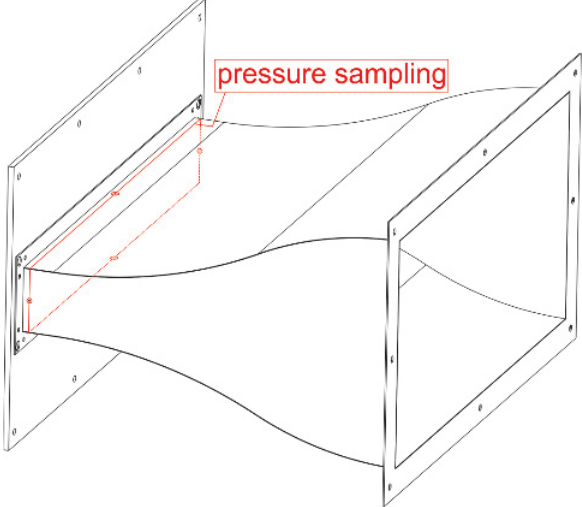
Fig. 2. Geometry of nozzle with positions for pressure sampling.